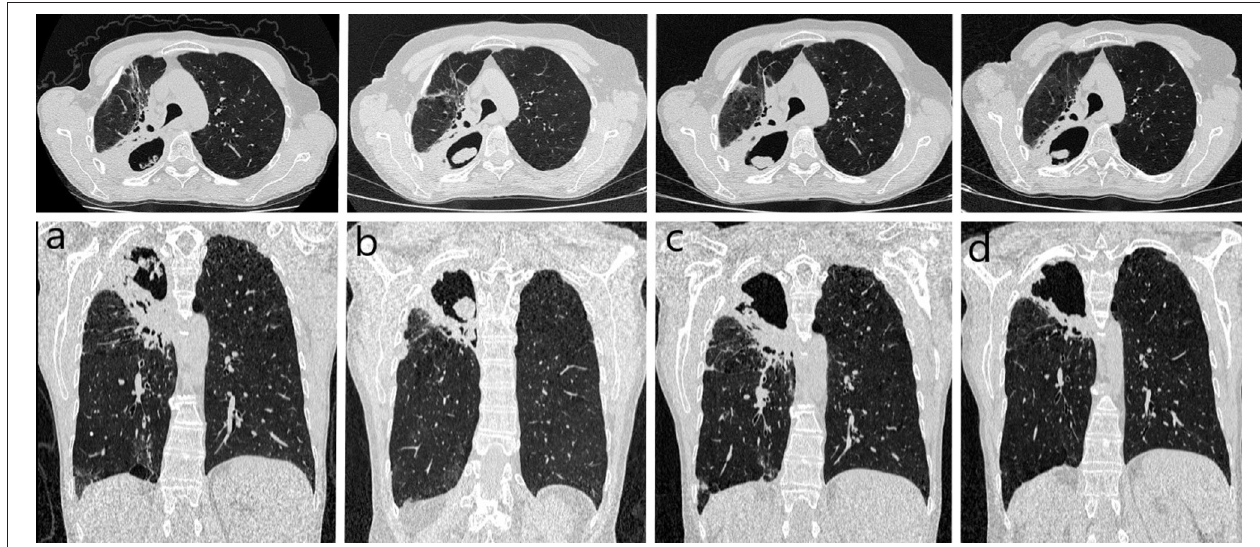
FIGURE 3 | Controlled chest computed tomography during first-line treatment in 2020: (a) at the beginning of the therapy – irregular cavity size 102 x 59mm in apical parts of the right lung, surrounded by solid consolidations widely adhere to the parietal pleura, connecting to the right hilum; (b) after 2 months – cavity with thick walls size 71 × 49mm, concomitant mass on the posterior wall-size 29 x 10mm; (c) after 4 months – cavity with thick walls size 69 × 47mm, concomitant mass on the posterior wall-size 14 x 5mm; (d) after 6 months – image stabilization.